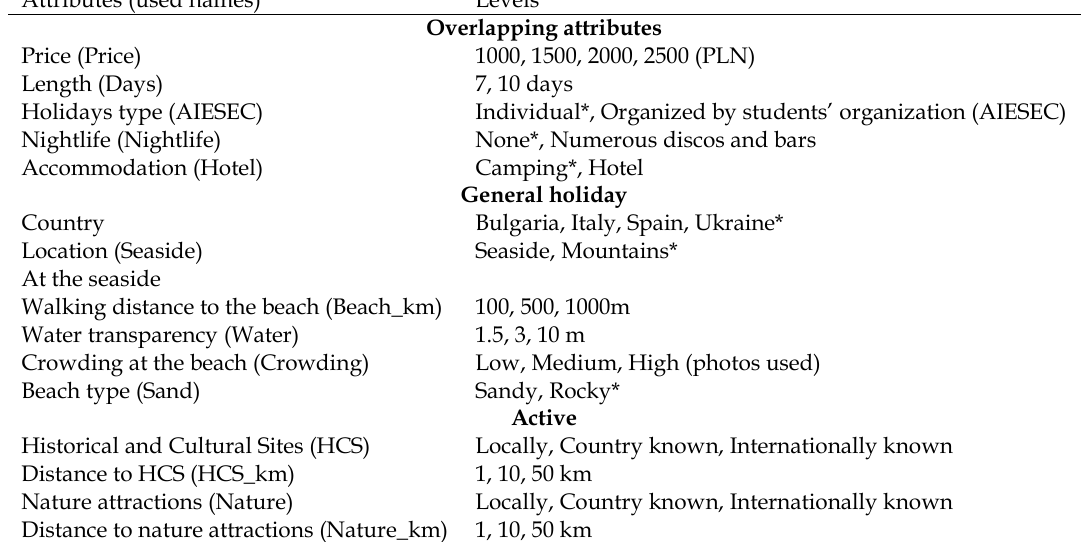
Table 3. Experimental design setup for the holiday dataset